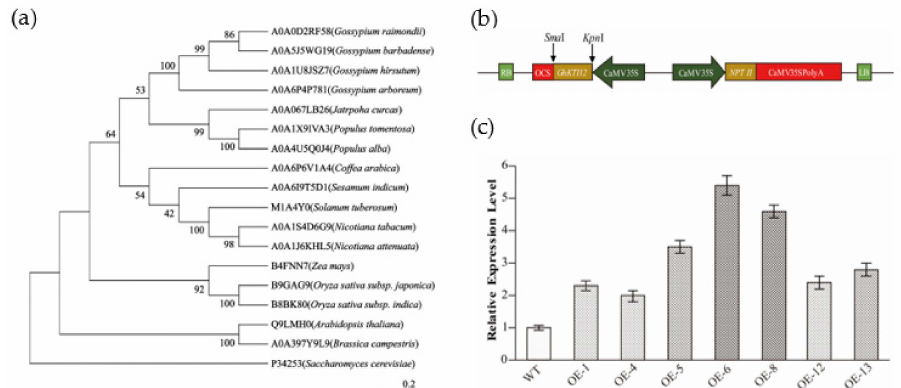
Figure 1. Phylogenetic analysis of GhKTI12 homologs and identification of transgenic plants. ( a ) Phy- logenetic analysis of GhKTI12 homologs in plants. NJ tree is generated by MEGA-X software using full protein sequences. Numbers in each branch indicate distance genetic variation between species. GhKTI12 was shown as A0A1U8JSZ7 (upland cotton). ( b ) Vector constructions of GhKTI12 based on PCAMBIA2300-35S backbone. ( c ) qRT-PCR analysis of relative transcript level of GhKTI12 in T0 transgenic tobacco lines (Line 1–7). Bars in the graph show the standard mean error. Asterisks indicates significant differences between wild type (WT) and GhKTI12 transgenic plants analyzed by Student’s t -test, p <